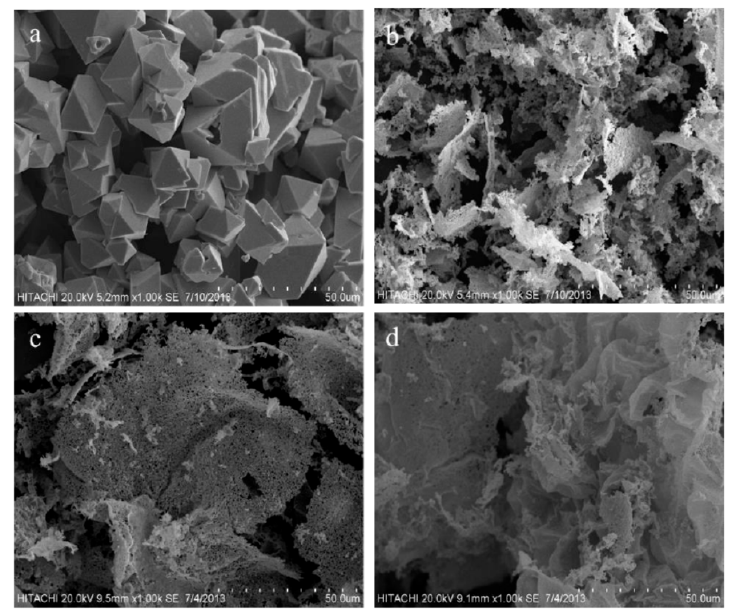
Figure 2. SEM images (50 μ m) of CdO nanoparticles at PVP different concentration of ( a ) 0.00; ( b ) 0.03; ( c ) 0.04, and ( d ) 0.05 g/mL.